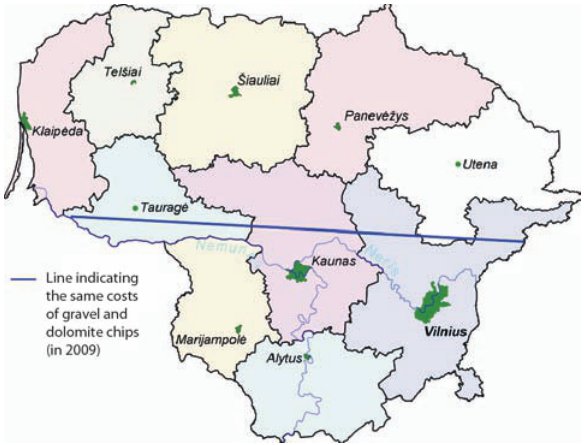
Fig. 3. Average theoretic straight line showing where the prices of the delivered crushed dolomite and crushed gravel in 2009 were the same